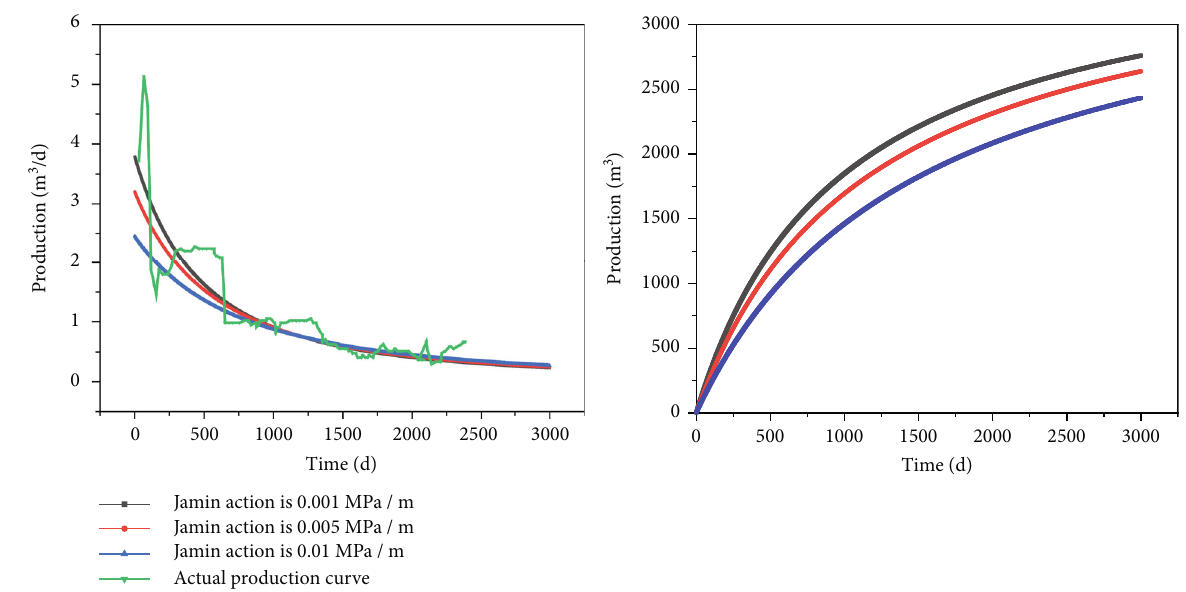
Figure 16: Diagram showing the e ff ect of di ff erent scales of the Jamin e ff ect on the